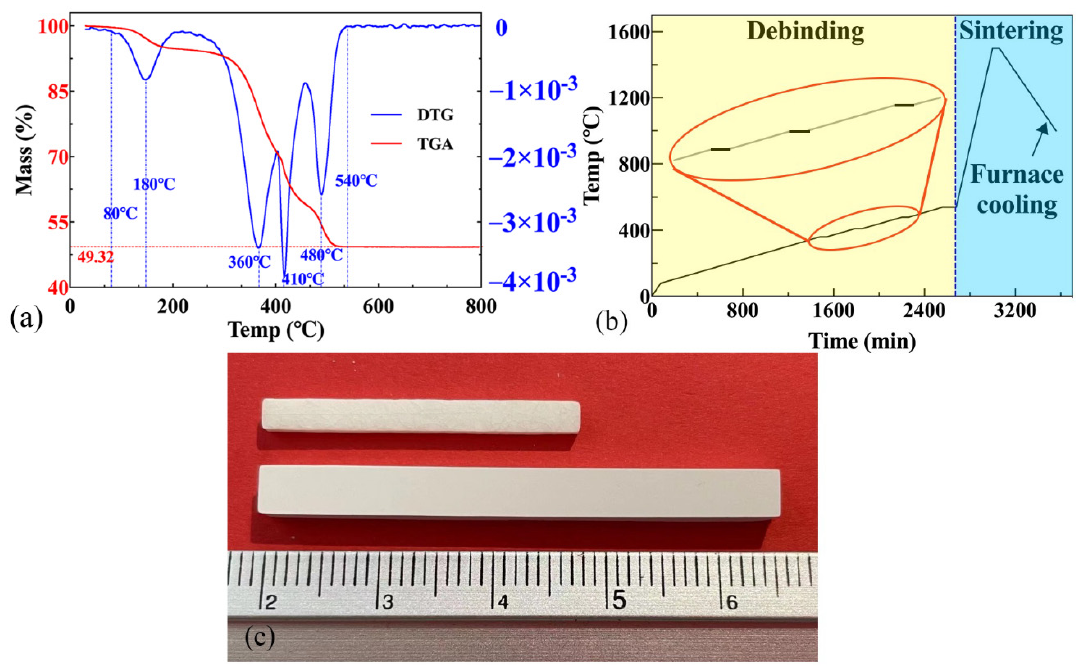
Figure 3. ( a ) The TG/DTG curves, ( b ) the debinding and sintering profiles of the green body and ( c ) the samples of before (below) and after (top) sintering.